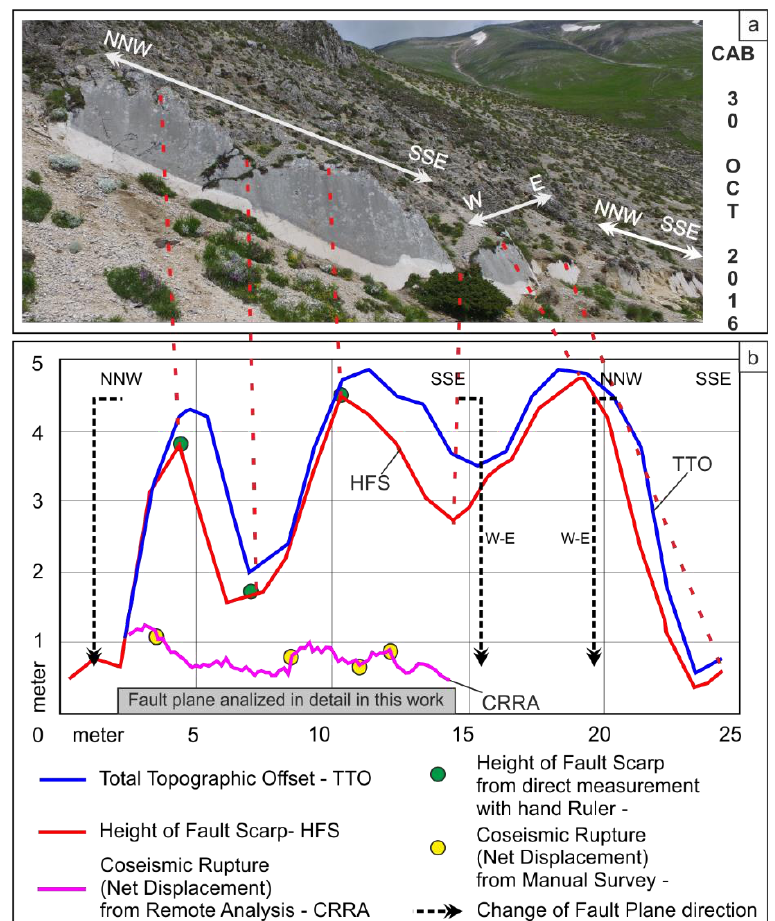
Figure 8. ( a ) Outcrop image of the CAB fault; ( b ) Comparison of di ff erent types of topographic profiles; blue line: height of long term slope; red line: e ff ective present fault scarp; violet: coseismic net displacement. Both along-strike distance (abscissa) and height values (ordinate) are expressed in meters. Colored dots refer to field measurements collected at control points.